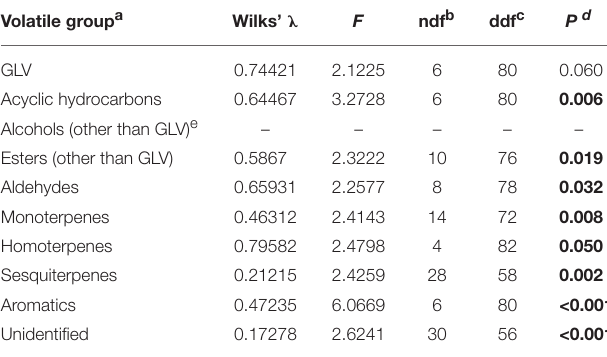
TABLE 1 | Results of MANOVA for the effects of teosinte population on plant volatile